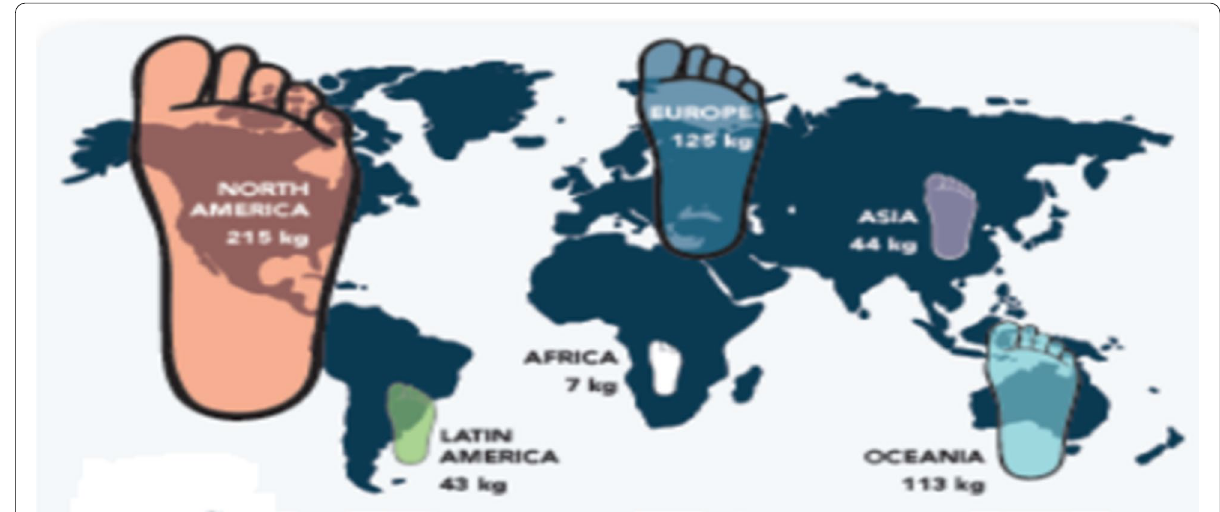
Fig. 2 Global consumption of paper by major countries